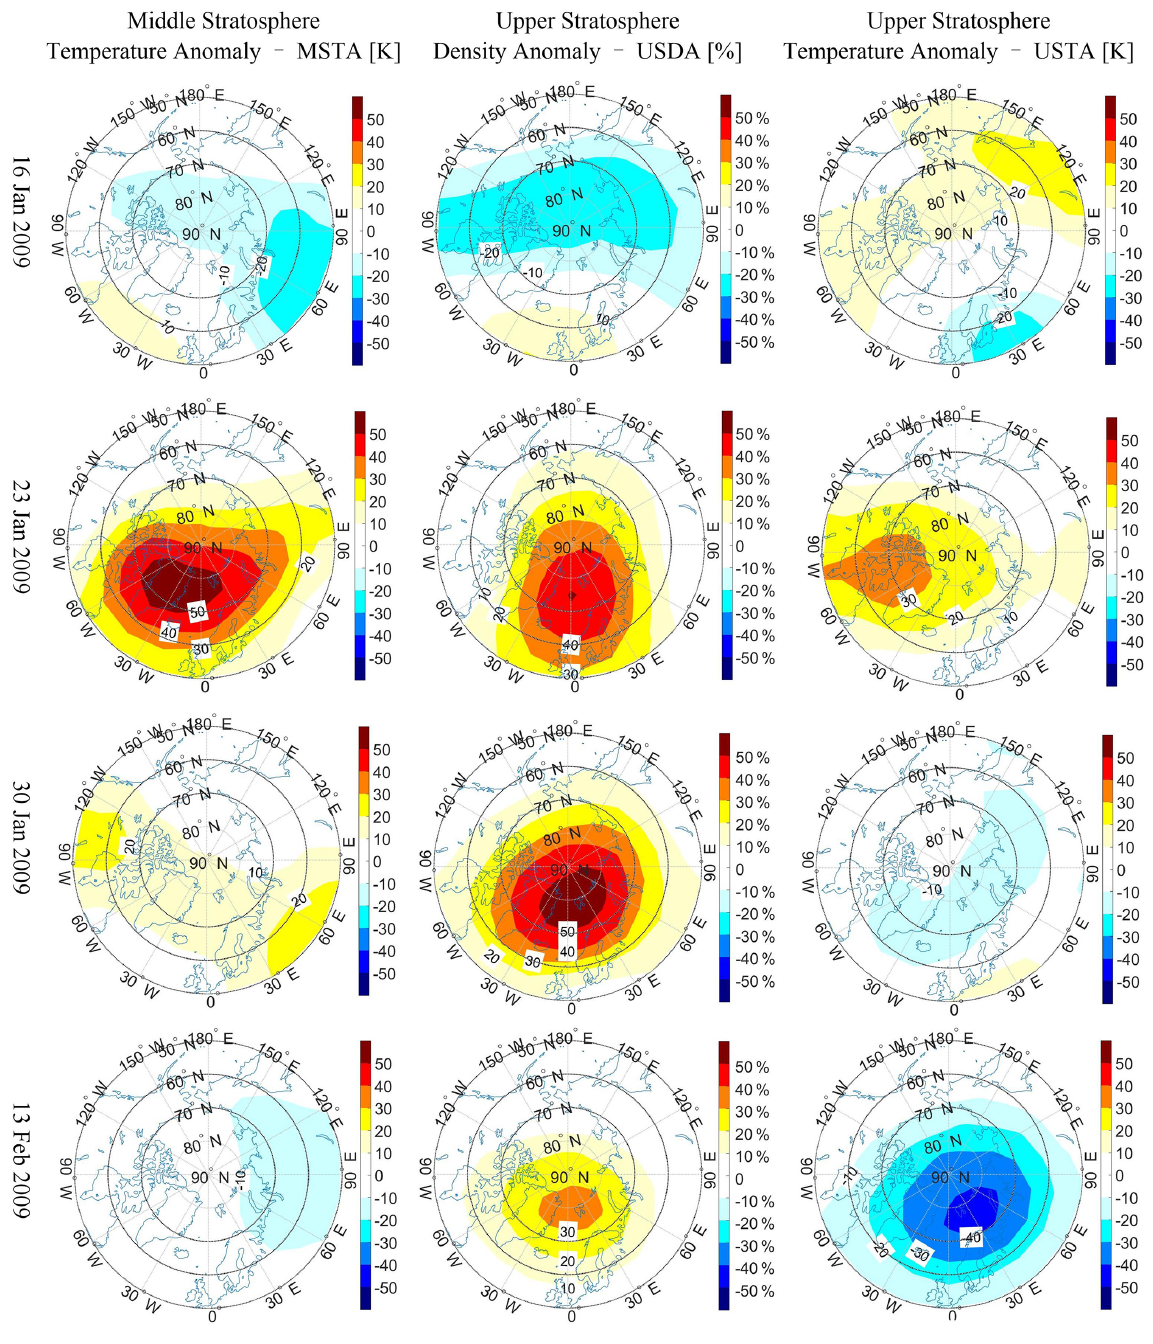
Figure 5. Middle stratosphere temperature anomaly (MSTA; left column), upper stratosphere density anomaly (USDA; middle column), and upper stratosphere temperature anomaly (USTA; right column) on the 4 exemplary days of 16, 23, and 30 January and 13 February 2009, illustrating the space–time dynamics of the SSW event in these three anomaly